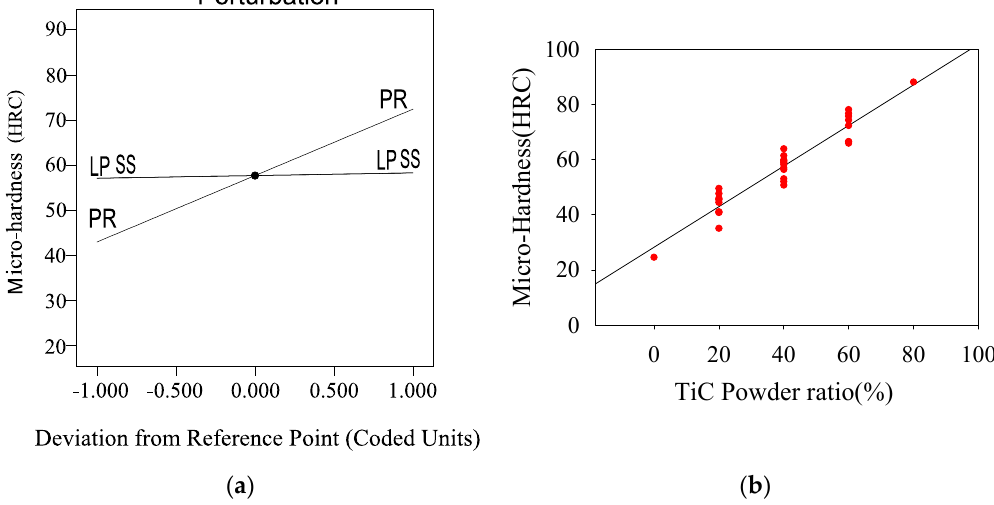
Figure 5. ( a ) Influence on micro-hardness by different LENS process parameters; ( b ) The plot of micro-hardness to TiC powder ratio.